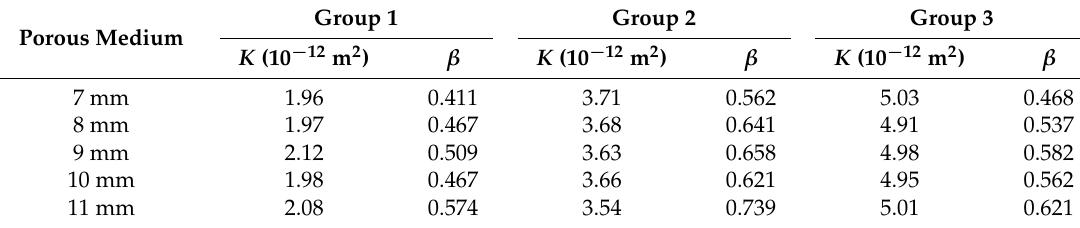
Table 4. Results of fitting coefficients K and β by the discharge method.